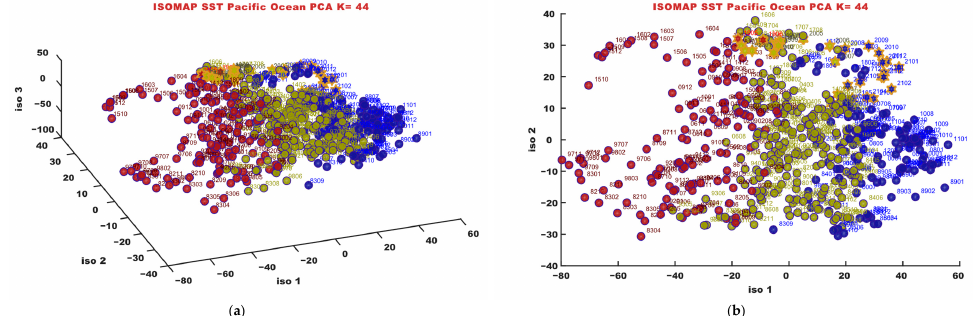
Figure 3. ( a ) 3D structure composed of the three leading ISOMAP components. ( b ) 2D structure composed of the two leading ISOMAP